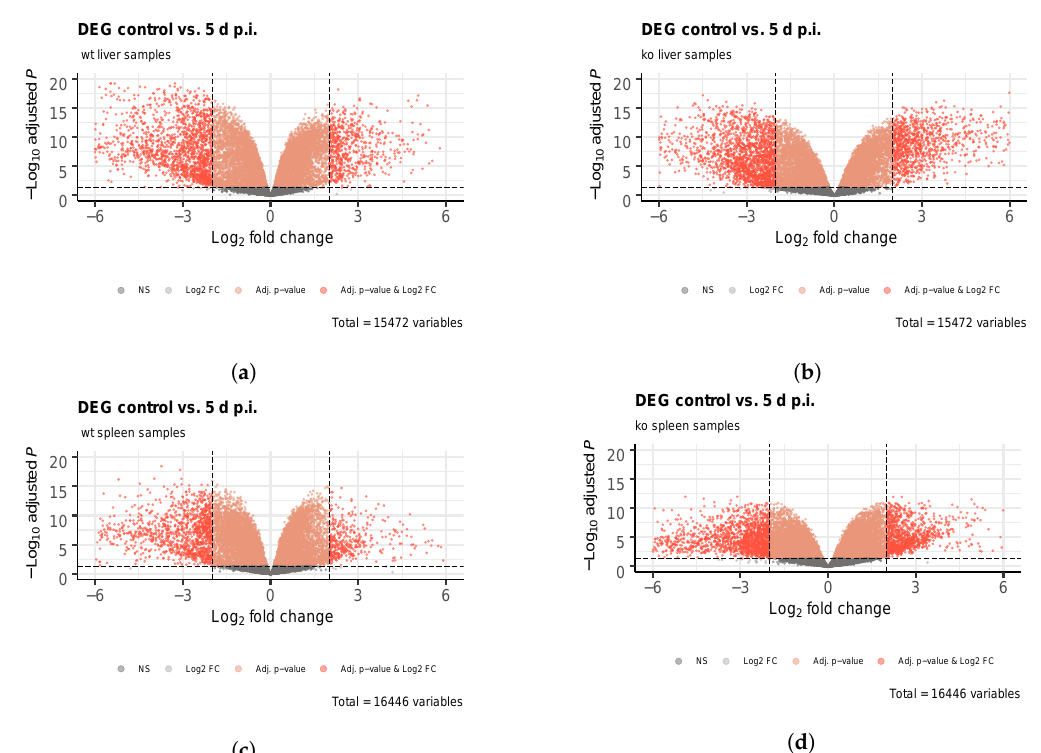
Figure A3. Volcano plots showing the differentially-expressed genes (DEG) that proceeded to the analyses. DEG were filtered by log2FC ≥ 2 and adjusted p value ≤ 0.05. These comparisons were performed both organ and genotype-wise: ( a ) liver wt , ( b ) liver ko , ( c ) spleen wt , ( d ) spleen ko . ko , Ly6E ∆ HSC .